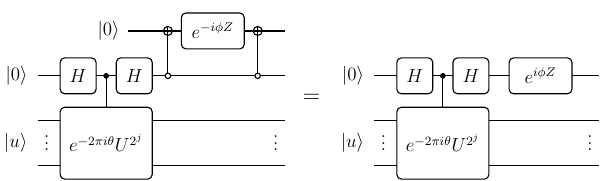
FIG. 13. The simplification of QSP phase control for the case when the block-encoded operator has an accessible control